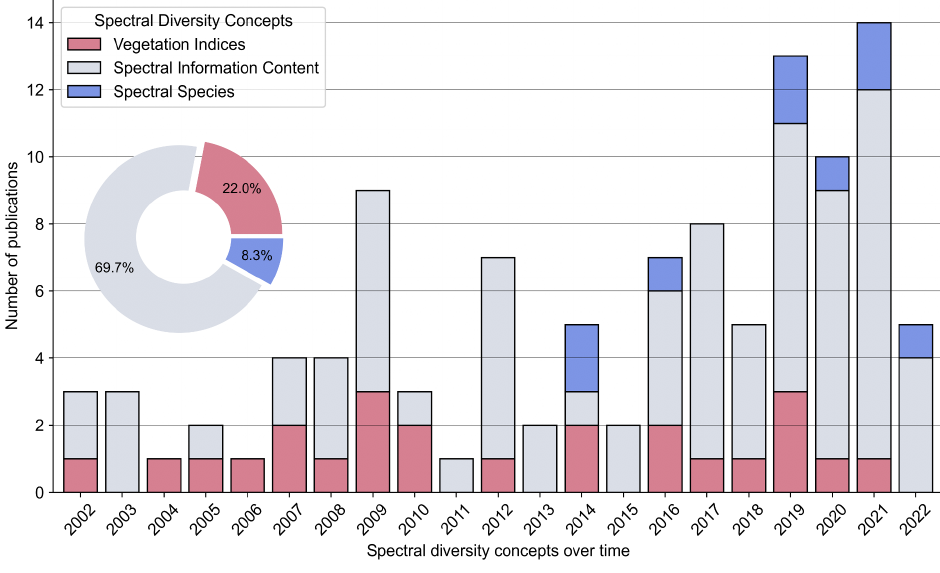
Figure 11. Temporal distribution of the reviewed articles grouped by the spectral diversity concepts vegetation indices, spectral information content, and spectral